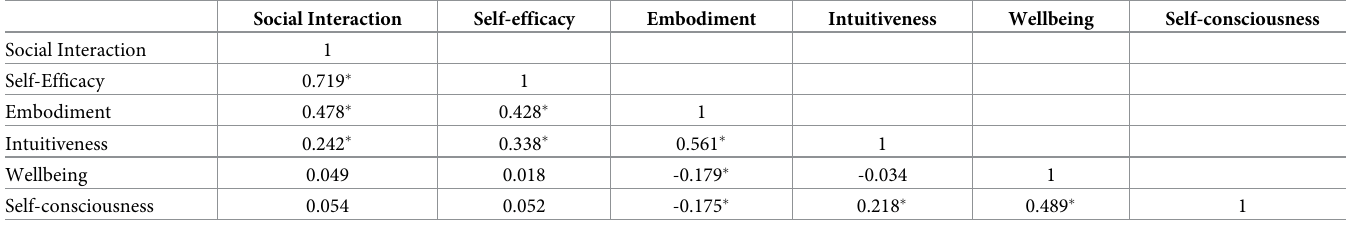
While prior work utilized an earlier prototype of the PEM to study the psychosocial experience of persons with sensory enabled prostheses, this is the first study that examined the Table 6. Factor correlations in final CFA (N =